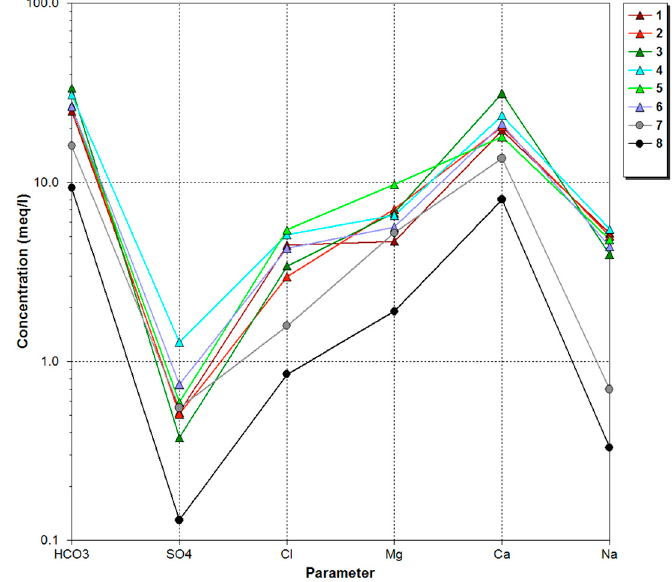
Figure 11. Schoeller diagram of spring and well waters. Triangles are relative to sulfurous thermal waters; circles are relative to cold waters. 1, S. Stefano spring (Corniello and De Riso, 1986); 2, Pera spring (Impresa Minieri S.p.A, 2000); 3, Goccioloni well (Impresa Minieri S.p.A, 2017); 4, Diana well (Impresa Minieri S.p.A., 2018); 5, Bouvette well (Corniello and De Riso, 1986); 6, S. Lucia spring (Harabaglia et al., 2002); 7, Cerro spring (Corniello and De Riso, 1986); 8, Grassano spring (Corniello and De Riso, 1986).